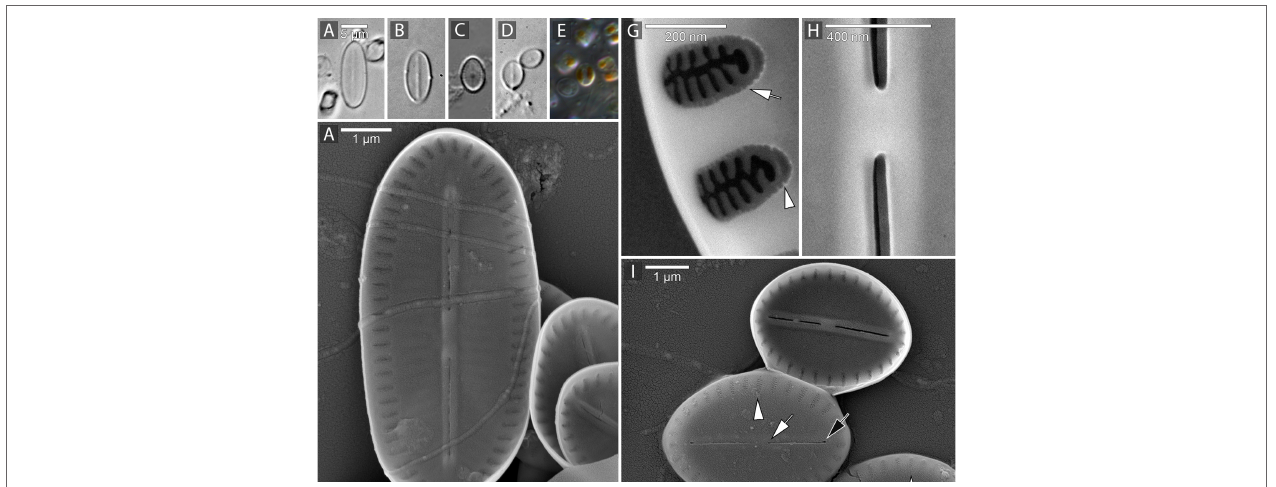
FIGURE 3 | Amicula micronesica Lobban, Ashworth & Witkowski sp. nov. Figures (A–D) . Light microscopic images of A micronesica from the holotype slide, holotype specimen in Figures (B, E) Specimen of A micronesica from the culture with two plastids. Figures (F–I) . Specimens of A micronesica illustrated in SEM. Figure (F) Specimen illustrating valve internal view with relatively short raphe branches and relatively large central nodule. Figure (G) Internal valve view illustrating the cribrate areola (white arrow) and remnants of the hymenate internal occlusions (white arrowhead). Figure (H) close up of the internal central raphe endings. Figure (I) Internal and external valve view note the external view of the areola occlusions (white arrowheads), the central external raphe end (white arrow) and external apical raphe end distant from the valve apex (black